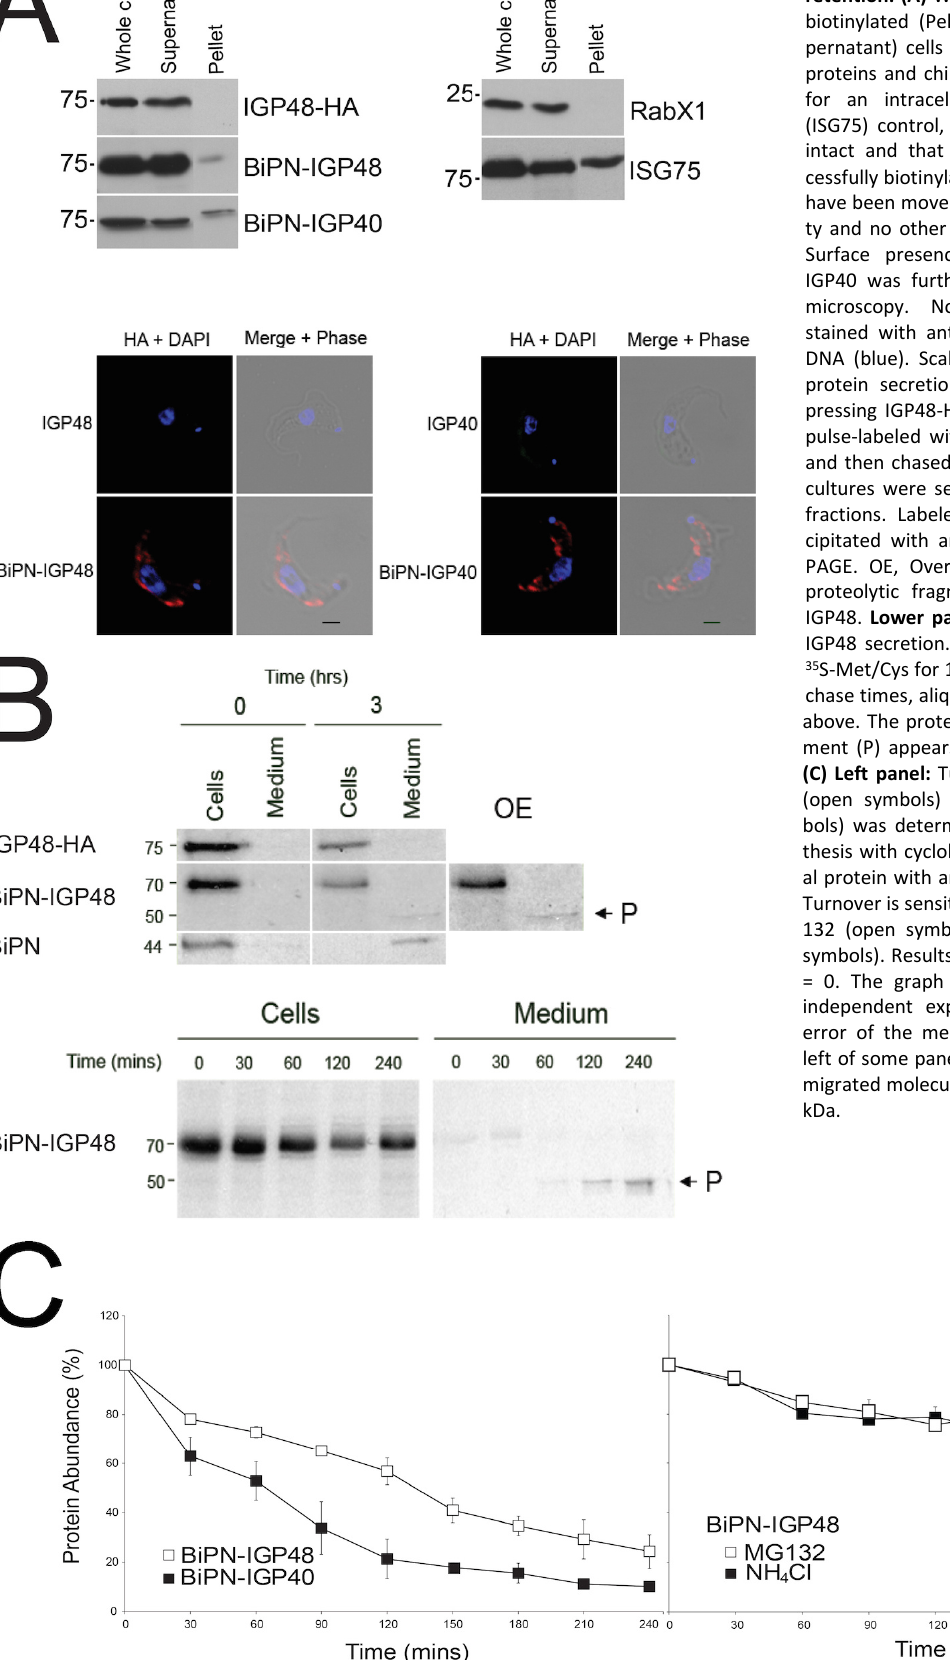
FIGURE 5: The IGP ectodomain is required for retention. (A) Western blot analysis of surface- biotinylated (Pellet) and non-biotinylated (Su- pernatant) cells to detect surface-exposed IGP proteins and chimeras. Blots were also probed for an intracellular (TbRabX1) and surface (ISG75) control, to demonstrate that cells are intact and that surface components are suc- cessfully biotinylated. Note that the Pellet lanes have been moved in Photoshop simply for clari- ty and no other manipulation has taken place. Surface presence of BiPN-IGP48 and BiPN- IGP40 was further demonstrated by confocal microscopy. Non-permeabilised cells were stained with anti-HA antibodies (red) and for DNA (blue). Scale bar = 1 μm. (B) Kinetics of protein secretion. BSF trypanosome cells ex- pressing IGP48-HA, BiPN-IGP48 and BiPN were pulse-labeled with 35 S-Met/Cys for 15 minutes and then chased for 3 hours. At 0 and 3 hours cultures were separated into cell and medium fractions. Labeled proteins were immunopre- cipitated with anti-HA and separated by SDS- PAGE. OE, OverExposure to reveal a 70 kDa proteolytic fragment (P) cleaved from BiPN- IGP48. Lower panel: Detailed kinetics of BiPN- IGP48 secretion. Cells were pulse-labeled with 35 S-Met/Cys for 15 minutes and at the indicated chase times, aliquots were treated as described above. The proteolytic BiPN-IGP48 50 kDa frag- ment (P) appears in the medium after 1 hour. (C) Left panel: Turnover kinetics of BiPN-IGP48 (open symbols) and BiPN-IGP40 (closed sym- bols) was determined by blocking protein syn- thesis with cycloheximide and detecting residu- al protein with anti-HA antibodies. Right panel: Turnover is sensitive to inhibition by 10 µM MG- 132 (open symbols) or 20 mM NH 4 Cl (closed symbols). Results were normalised to 100% at t = 0. The graph represents the mean of two independent experiments, with the standard error of the mean indicated. Numbers to the left of some panels indicate the positions of co- migrated molecular weight standards and are in